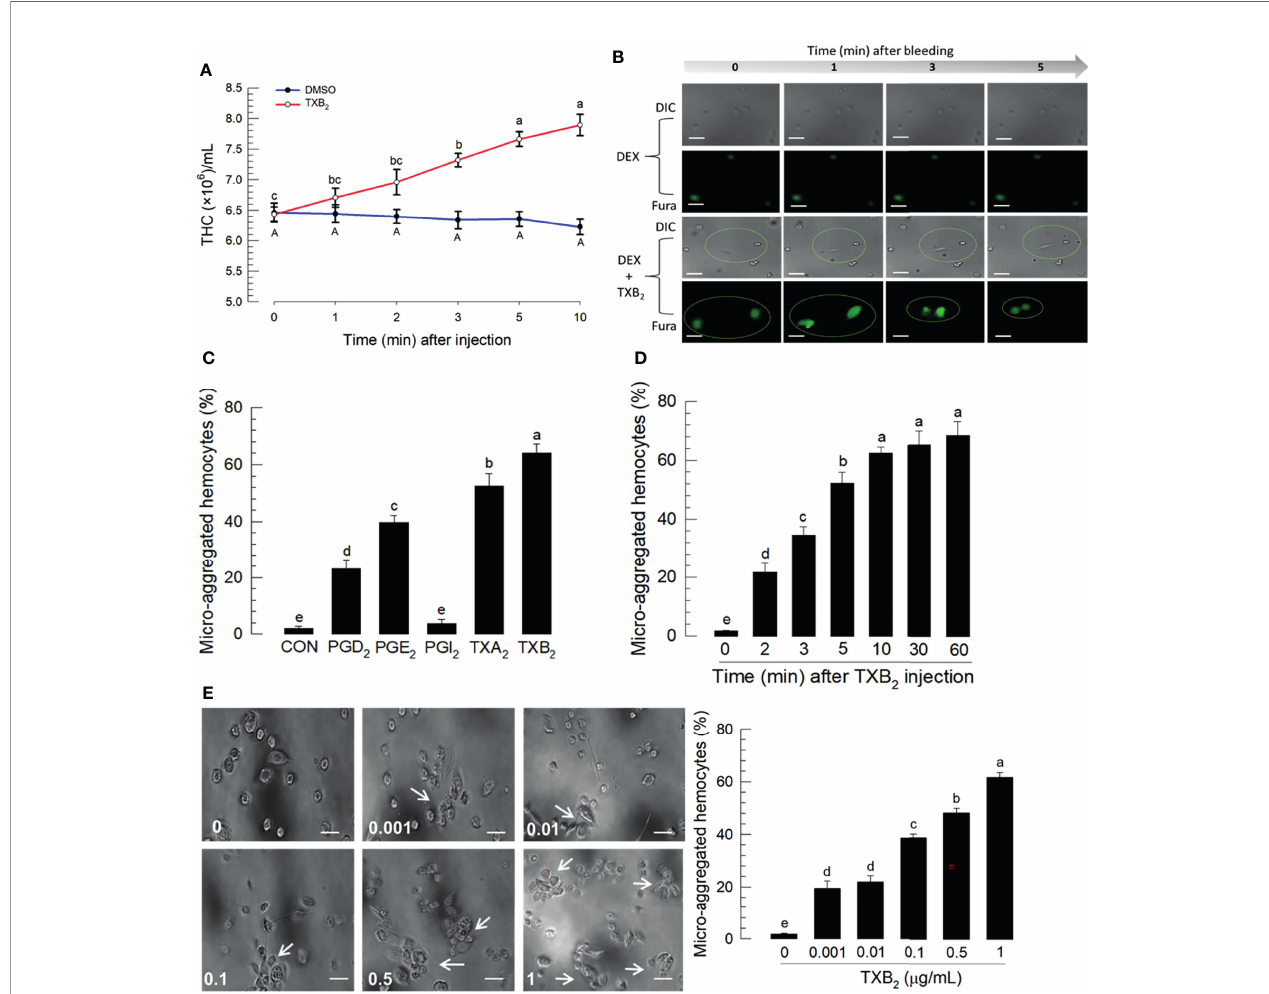
FIGURE 6 | In fl uence of time on hemocytic immunity in S. exigua . Panel (A) depicts time-dependent up-regulation of total hemocyte count (THC) in L5 larvae after TXB 2 injection at 1.0 µg/larva. Panel (B) displays hemocyte migration activated by TXB 2 as a function of time after hemolymph collection, inhibited in DEX- treated larvae, and rescued in DEX+TXB 2 -treated larvae. Dotted circles indicate hemocyte migration. Panel (C) shows the in fl uence of PGD 2 , PGE 2, and the two thromboxanes on hemocyte microaggregation. Panel (D) depicts the time-dependent hemocyte microaggregation following larval TXB 2 injection 1 µg/mL in in vitro hemocyte preparations. Panel (E) shows dose response of the hemocyte migration 10 min after TXB 2 treatment in in vitro hemocyte preparations from naïve larvae. The white arrows point to microaggregates. ‘ DIC ’ represents differential interference contrast. Each treatment was replicated three times. Data analyzed and presented as described in Methods . Different letters above standard deviation bars indicate signi fi cant difference among means at Type I error = 0.05 (LSD